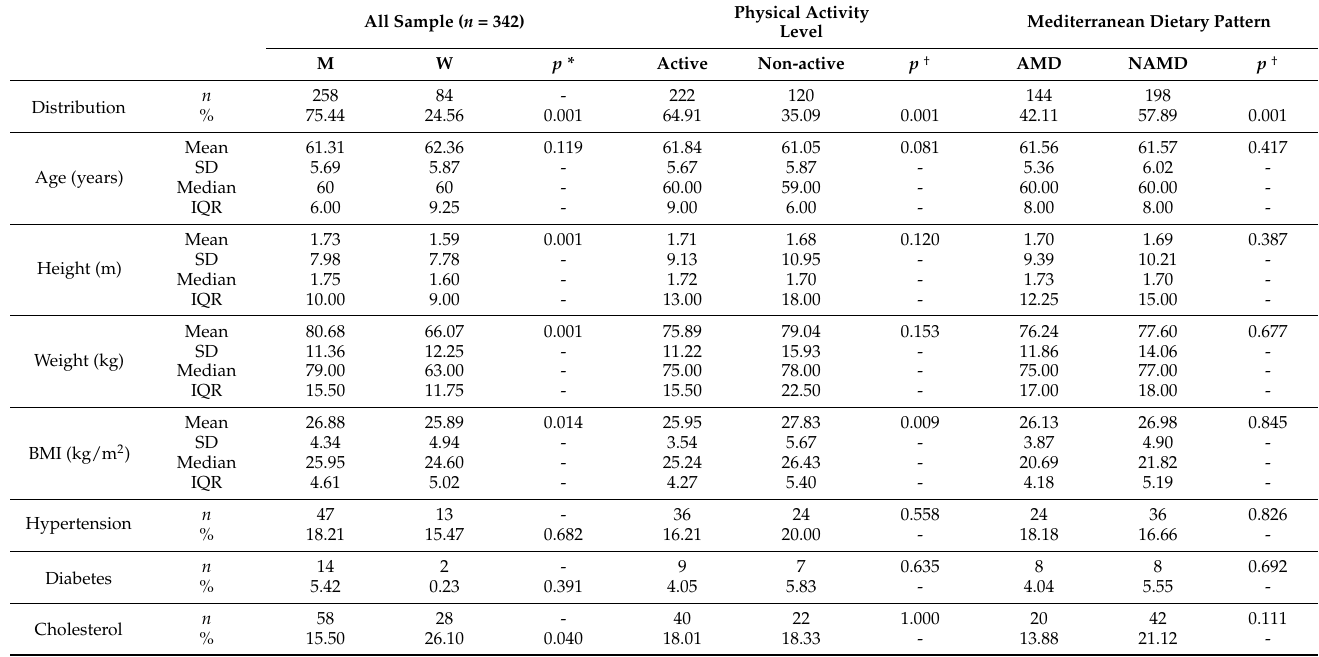
Table 1. Sample characteristics were classified by gender, physical activity level and adherence to the Mediterranean